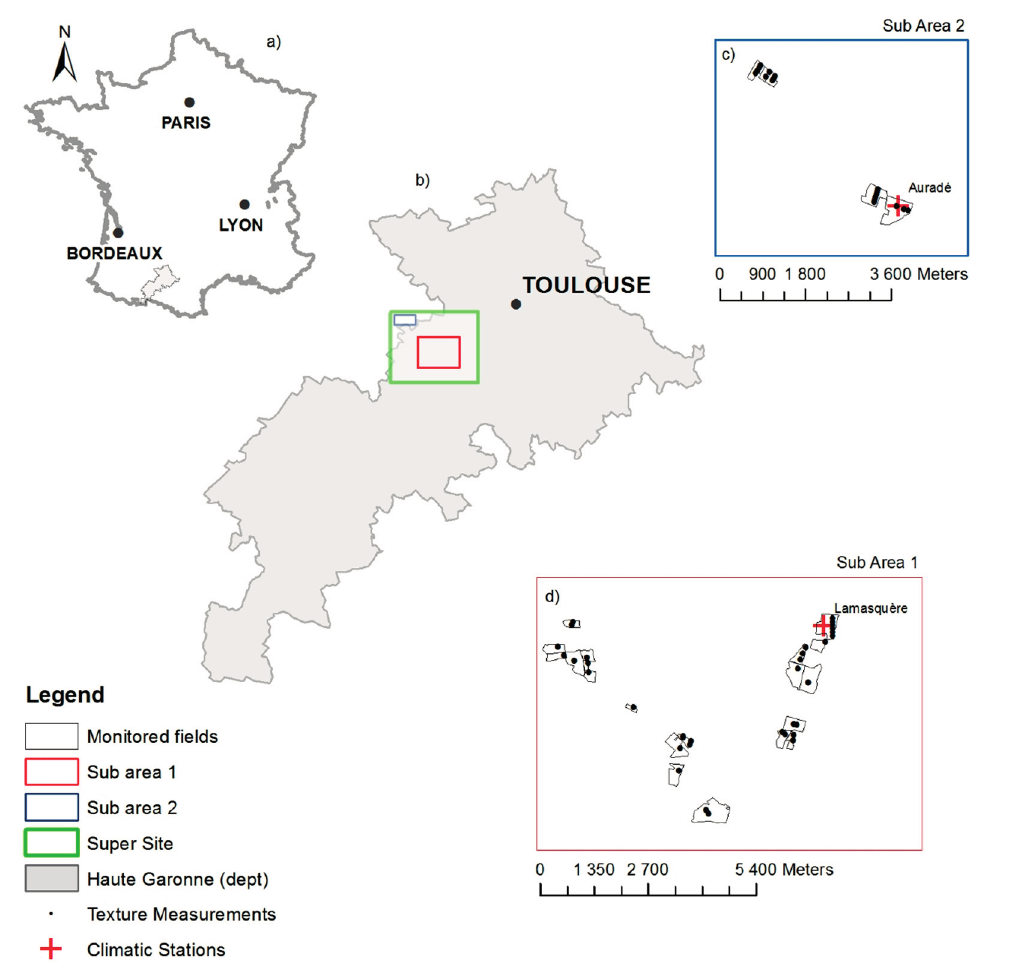
Figure 1. The studied site is located in the southwestern France, in the department of Haute Garonne ( a ), including two sub-areas named “Lamasquère” (red empty rectangle) and “Auradé” (blue empty rectangle) ( b – d ). Texture measurements are shown as black dots, within the agricultural plots (c and